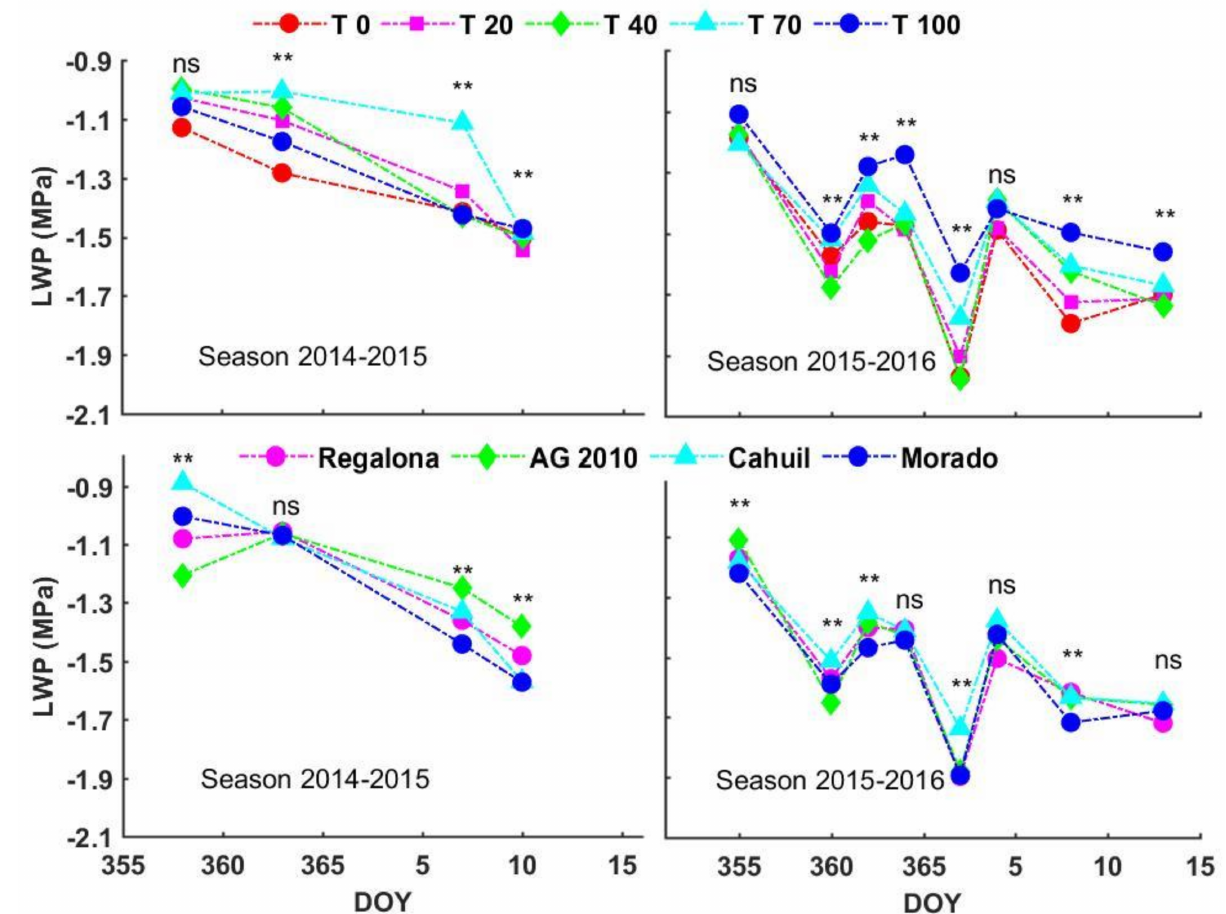
Figure 4. Leaf water potential (LWP) at midday under five irrigation treatments (T) and four quinoa genotypes, between the beginning of grain filling throughout the physiological maturity stages, in the 2014/2015 and 2015/2016 seasons. T0, T20, T40, T70, and T100 represent the levels of available water to the plant in a 0.6 m deep root zone just before irrigation. For water availability treatments, each point represents the average of 16 measurements, and for genotypes, each point represents the average of 20 measurements. DOY is the day of year. **, measurement date indicating that significant differences were found. ns, measurement date indicating that no significant differences were